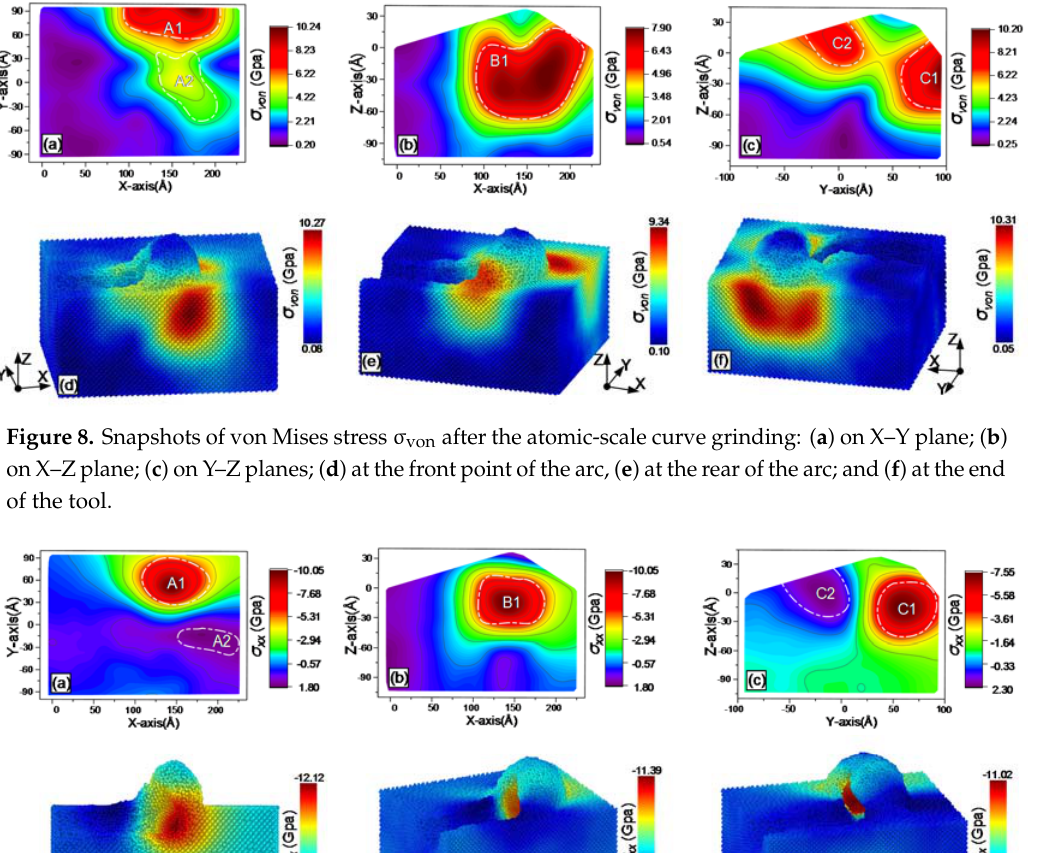
Figure 9. Snapshots of the normal stress σ xx after the atomic ‐ scale curve grinding: ( a ) on X–Y plane; ( b ) on X–Z plane; ( c ) on Y–Z planes; ( d ) at the front point of the arc, ( e ) at the rear of the arc; and ( f ) at the end of the tool.